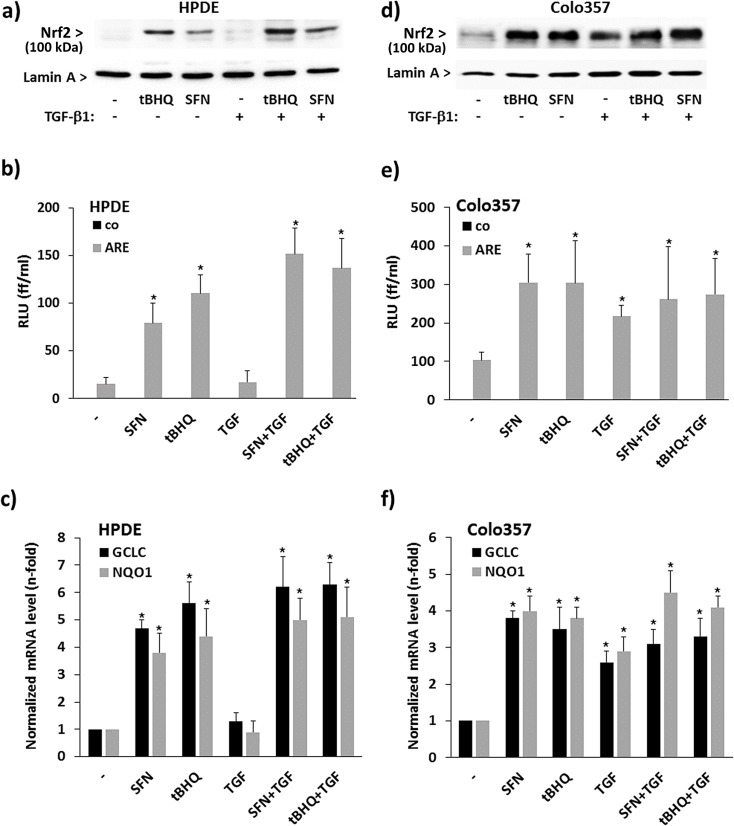
Interference of TGF-β1 with Nrf2 activation in premalignant and malignant pancreatic duct cells.HPDE or Colo357 cells either left untreated or treated for 8h with 50 μM tBHQ, 10 μM SFN or 10 ng/mL TGF-β1, either alone or in combination, were analysed by Nrf2 western blot (A,D) using nuclear extracts (lamin-A served as loading control), by ARE-luciferase assay (B,E) using an empty vector as control (co) and the pARE vector (ARE), or by real time PCR (C,F) for detection of the established Nrf2 target genes NQO1 and GCLC (TBP served as control). In A) and D) representative results from three independent experiments are shown. A densitometric band intensity evaluation is provided in Figs. A and B in S1 File. In B) and E) data represent the mean ± SD of four independent experiments performed in duplicate, and in C) and F) data represent the mean ± SD of six independent experiments. *p<0.05 (treated versus untreated).